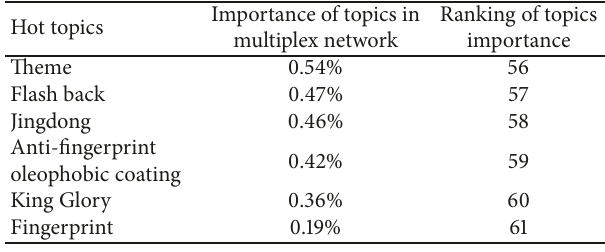
Table 11: The importance and its ranking of topics based on multiplex network.